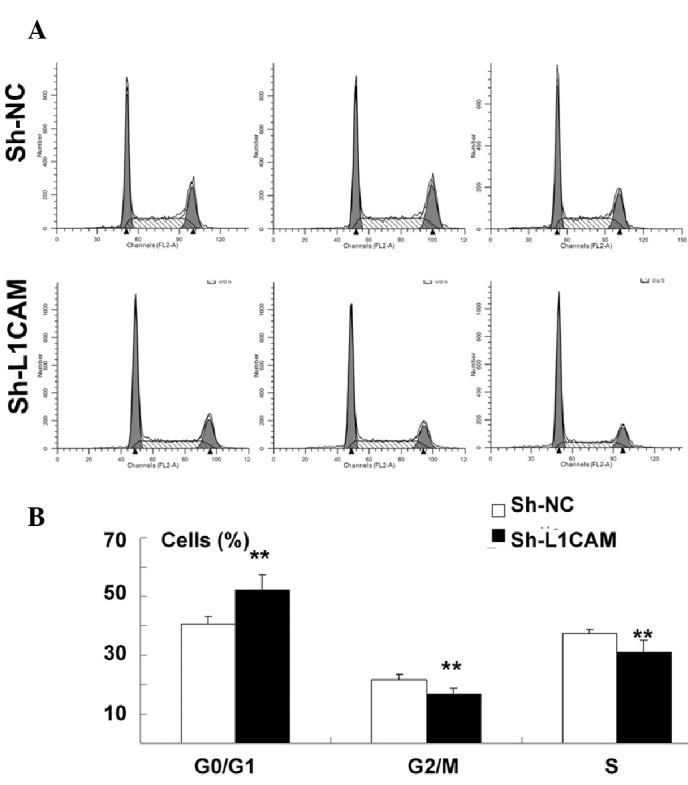
Effect of L1CAM silencing on Capan-2 cell cycle progression. (A) Flow cytometric histograms of the Capan-2 cells following silencing of L1CAM (Sh-L1CAM) in three parallel experiments. (B) Analysis of the cellular subpopulations at various phases of the cell cycle showed an increase in the percentage of cells at the G0/G1 phase, as well as a decrease in the percentage of cells at the G2/M and S phases, relative to the NC (Sh-NC). **P<0.01, vs. Sh-NC. NC, negative control; L1CAM, L1 cell adhesion molecule; Sh, short hairpin.